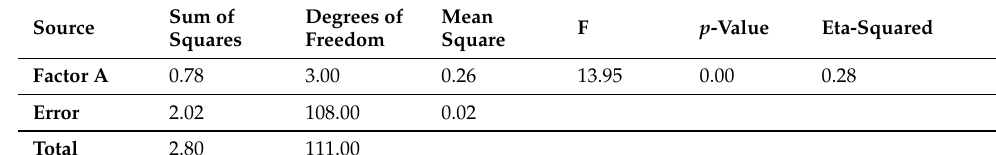
Table 16. Scenarios in the empirical